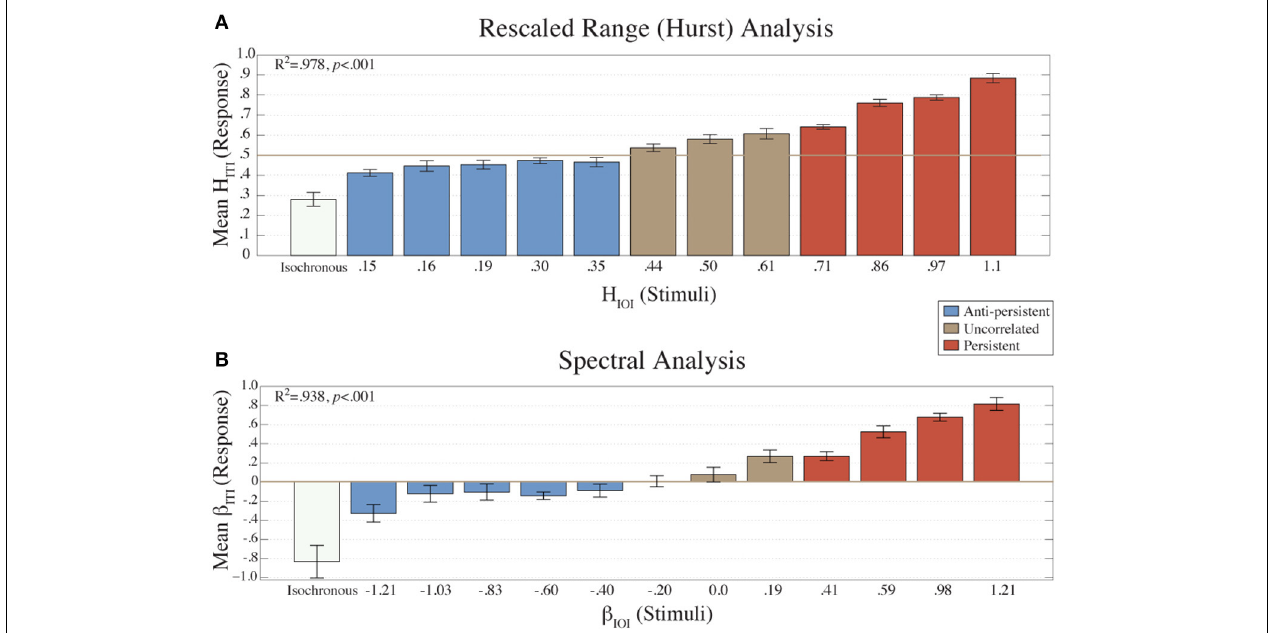
FIGURE 2 | The mean H ITI values ( N = 16) from the R/S analysis are plotted (A) for each condition ( H IOI ). The mean β ITI values ( n = 16) from the Power Spectral Density analysis are plotted (B) for each